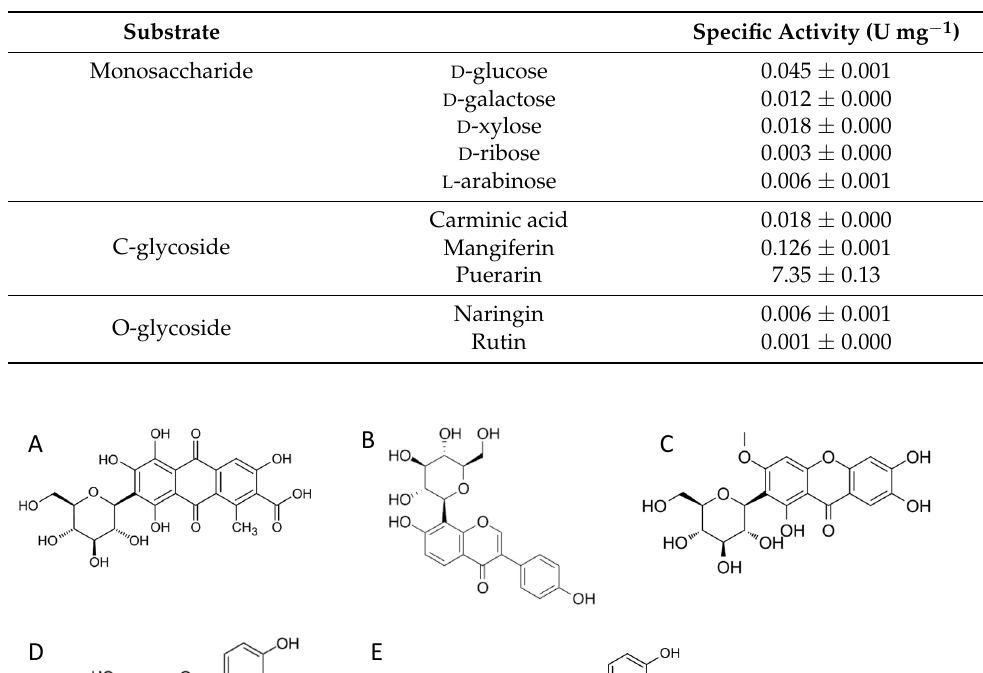
Figure 2. UV-Vis spectra of Sc POx in its oxidized form (solid line), after addition of 4 M D -xylose under aerobic conditions (dotted line) and of the supernatant after TCA precipitation (dashed line).